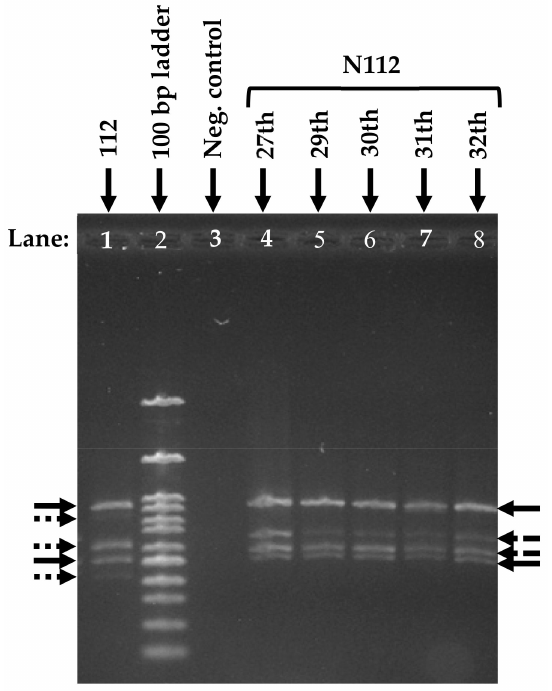
Figure 6. Change in the microbial community structure upon shifting from consortium 112 to N112. Here, the solid arrows represent similar bacterial species in the consortia, while the dotted (round or square) arrows represent the distinct bacterial species.